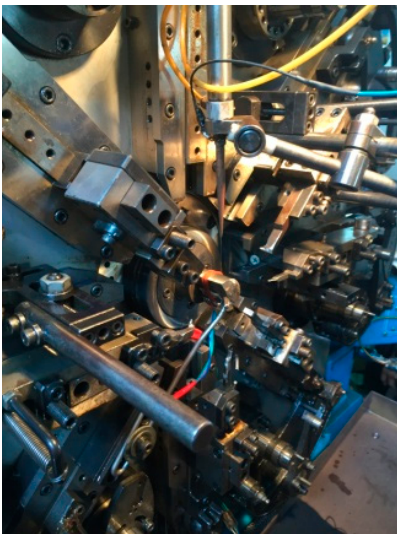
Figure 7. Spring fabrication machine used in experiment. Table 6. Jobs for the spring enterprise.